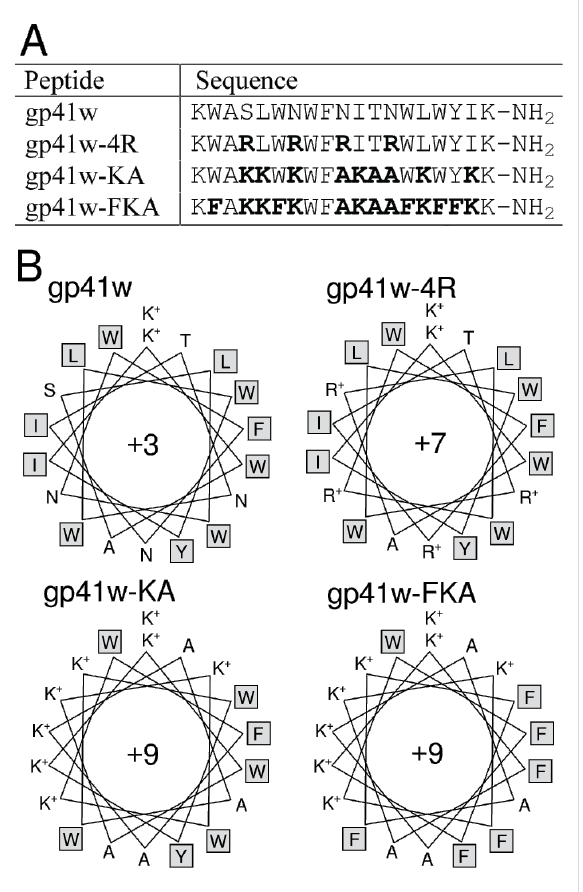
Figure 1: (A) Names and sequences of the gp41w-derived peptides. (B) Helical-wheel projections of gp41w, gp41w-4R, gp41w-KA and gp41w-FKA showing the hydrophobic and large aliphatic side chains in grey boxes. These helical wheels show the amphipathicity of the gp41w derivatives as the hydrophobic residues are increasingly segregated from the hydrophilic and charged